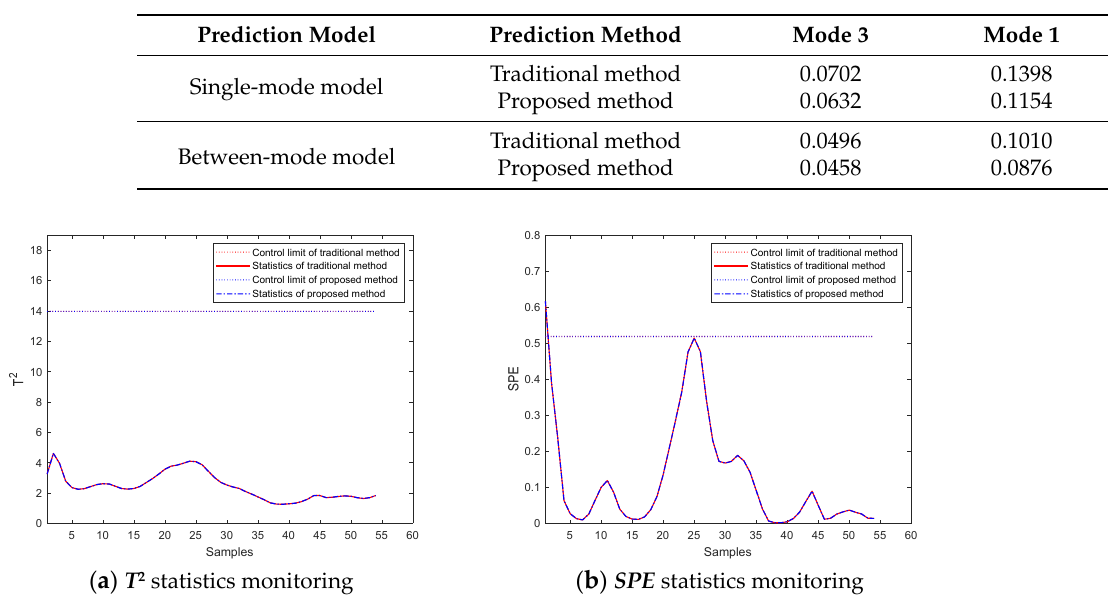
Figure 13. Multi-mode online monitoring of injection phase of mode 3.